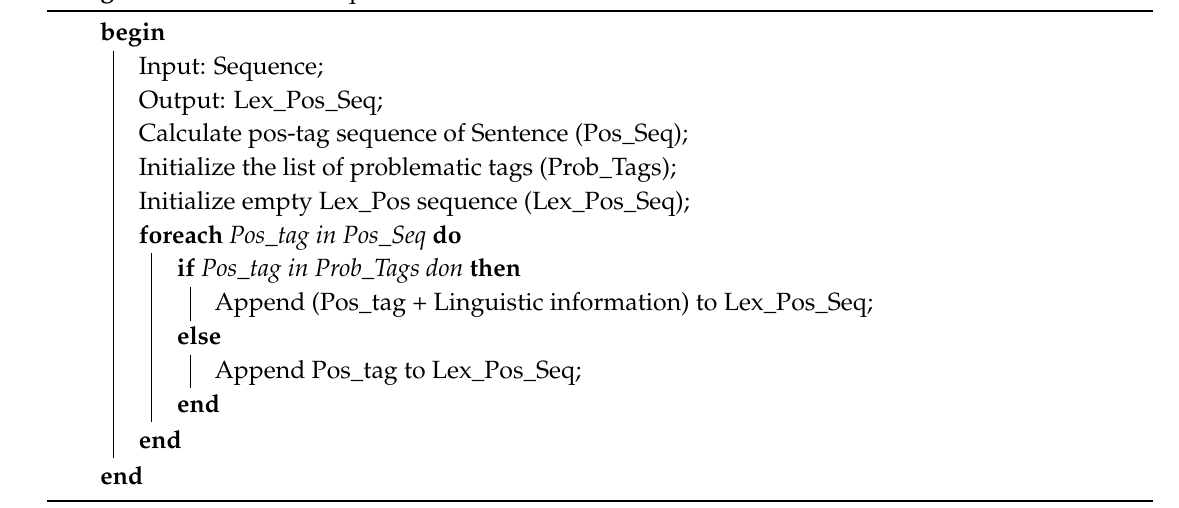
Algorithm 1: Lex-Pos